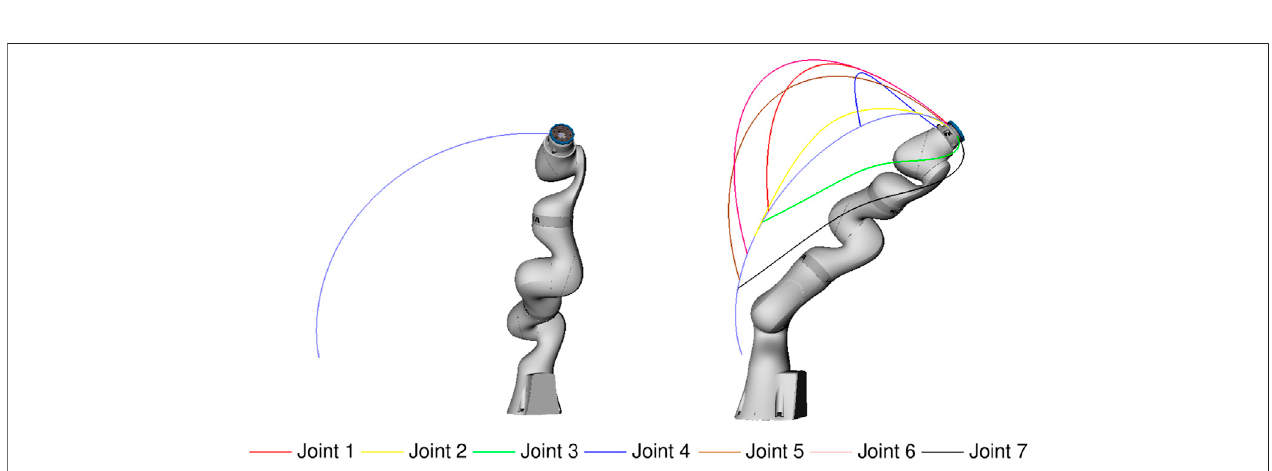
FIGURE 15 | Failure-tolerant path. Left: nominal, failure-free path. Right: collection of paths to recover from random failures in each joint (as indicated by the corresponding color code).